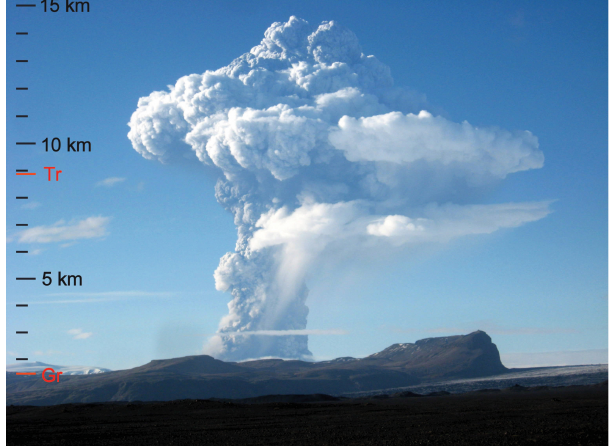
Figure 4. The initial Grímsvötn eruption plume seen from Skeiðarársandur, 50km south of the volcano. Approximate alti- tude scale at the distance of Grímsvötn (Gr) on the left, and the tropopause (Tr) at this time was at about 8.9km. Photo Bolli Val- garðsson, 21 May 2011 at